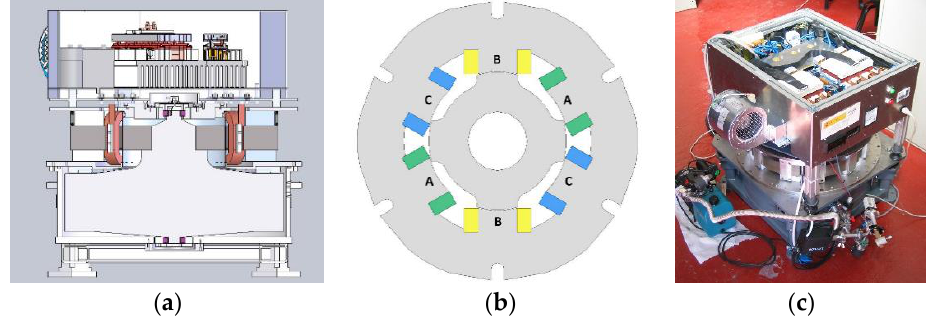
Figure 3. ( a ) 3D FESS unit scheme; ( b ) 2D representation of the electrical machine; ( c ) Flywheel unit module of the system.